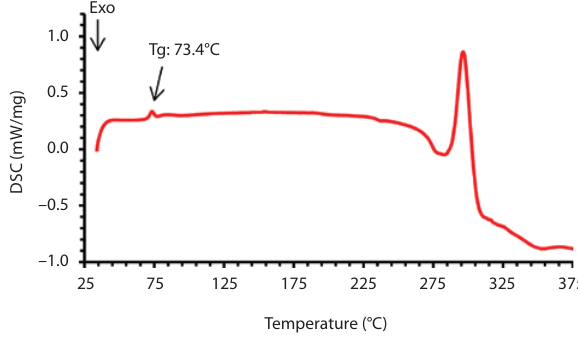
Figure 1: DSC curve of the used PVC (glass transition temperature: 73.4 ° C, beginning of degradation is at 270 ° C, and pick of degrada- tion is at 296 °